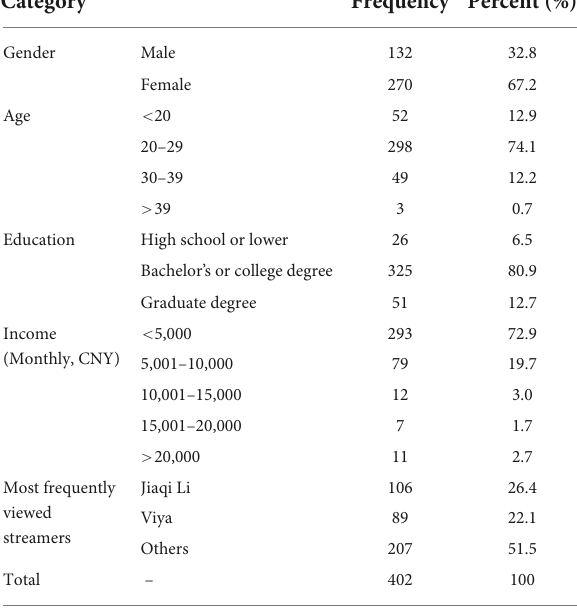
TABLE 3 Demographics of respondents ( n = 402). TABLE 4 Results of reliability and convergent validity